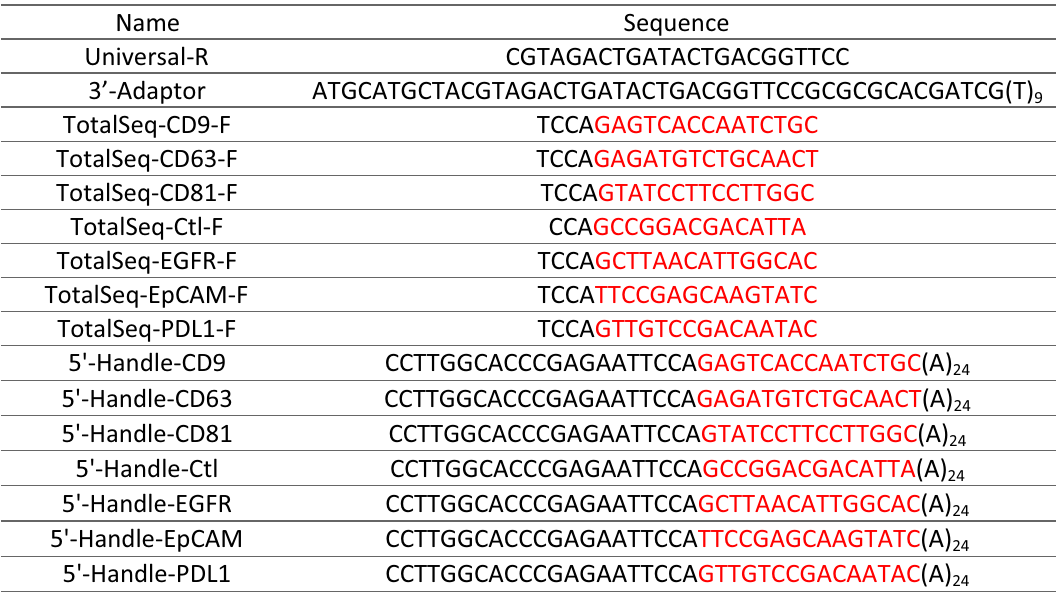
Table 4. Sequence of TotalSeq primers and oligos. *Barcode regions were shown in